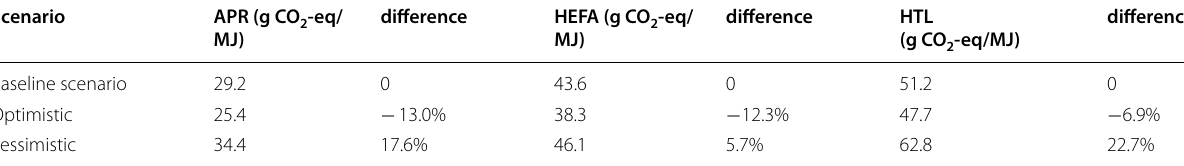
Table 5 Sensitivity analysis on conversion yield Scenario